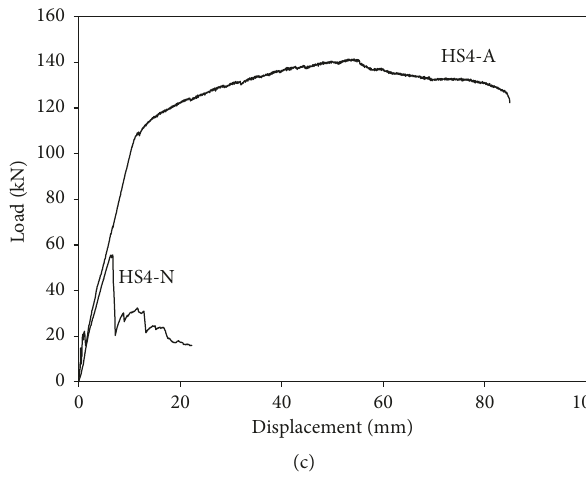
Figure 11: Load-displacement curve of UHPC shear specimens.